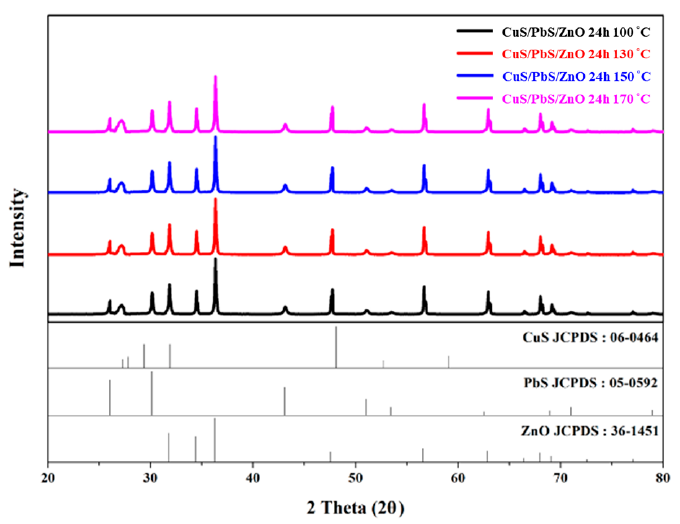
Figure 2. XRD analysis of CuS/PbS/ZnO heterojunction photocatalysts prepared under different hydrothermal temperatures.